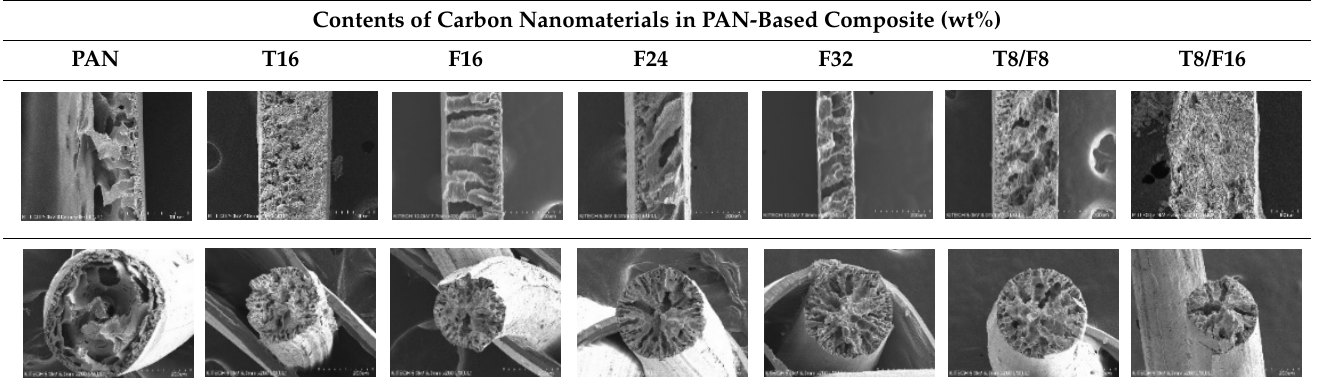
Table 5. Morphology of the PAN-based composite film and yarn with different contents of carbon nanomaterials (×200). Contents of Carbon Nanomaterials in PAN-Based Composite (wt%) PAN